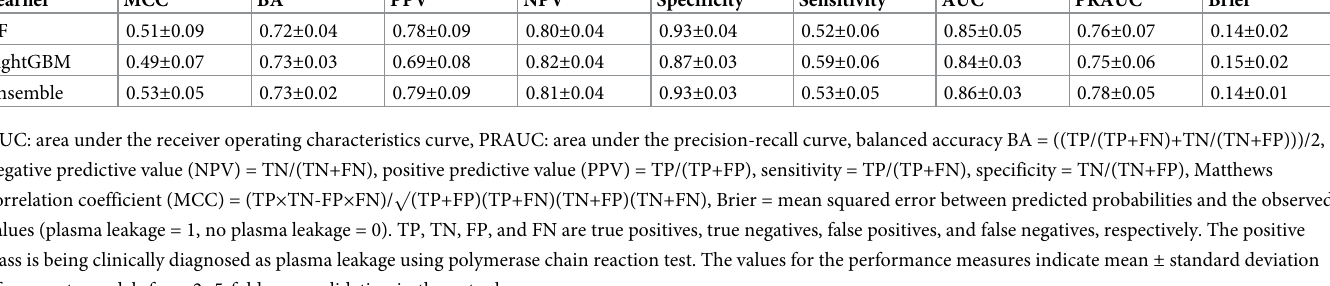
Table 2. Benchmarking results for random forest (RF), gradient boosting machine (LightGBM), and their average stacking (Ensemble) using the nested cross vali- dation on the development set.